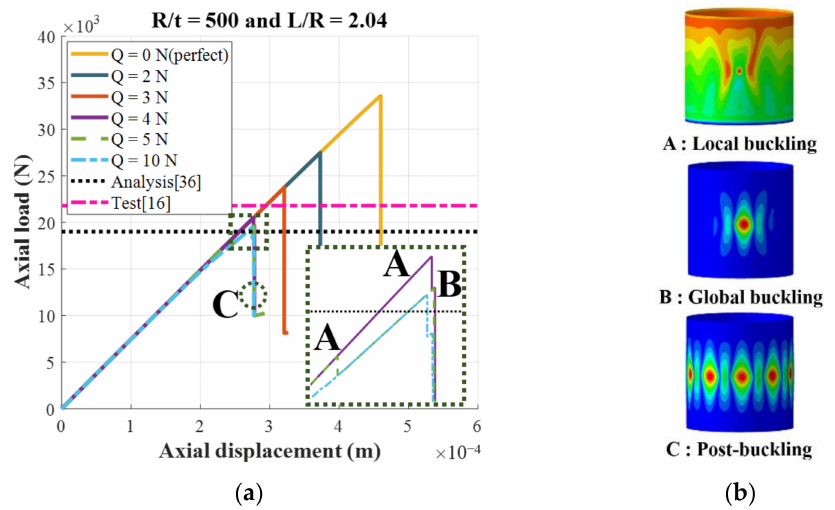
Figure 5. Post-buckling analysis results for Z07 composite cylinder. ( a ) Load-displacement curves, ( b ) Buckling